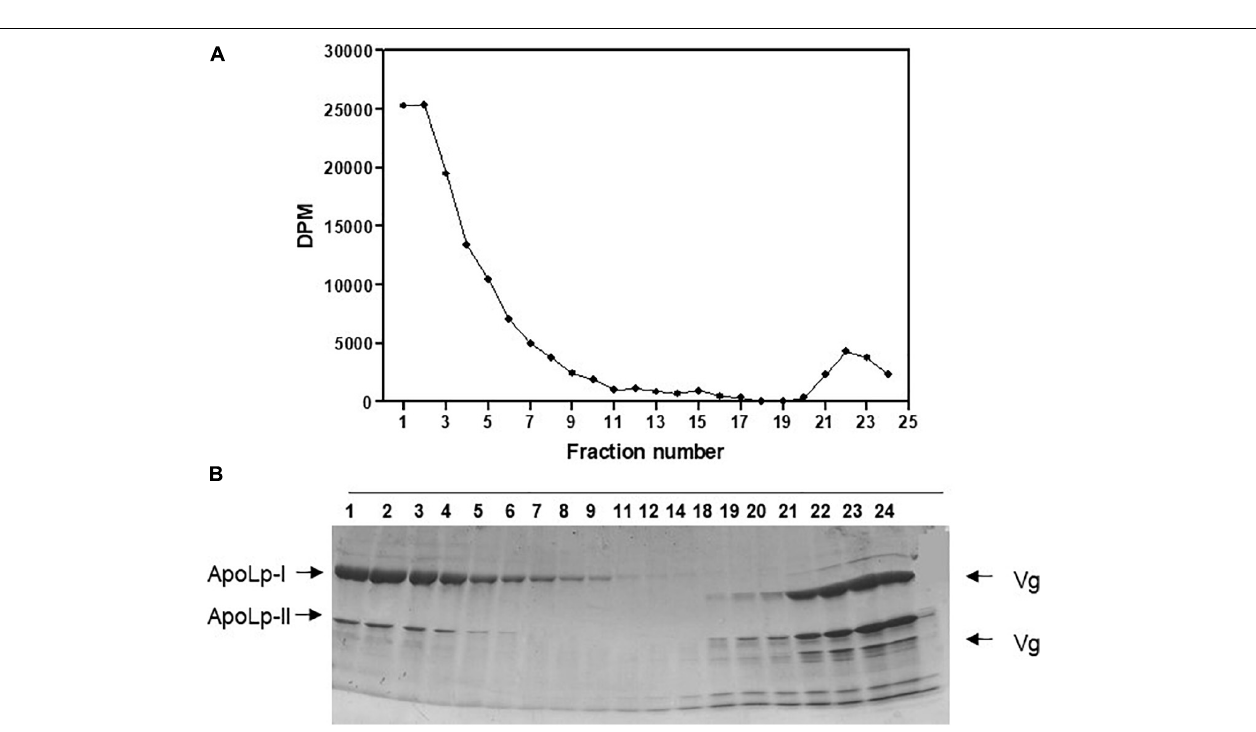
FIGURE 3 | Absorbed cholesterol associates with hemolymphatic lipophorin. Rhodnius prolixus adult females were fed on 3 H-cholesterol-enriched blood and on the sixth day after the blood meal hemolymph was collected and subjected to a density gradient ultracentrifugation. (A) Radioactivity present in gradient fractions was quantified and expressed as DPM/fraction. (B) Fractions were analyzed by SDS-PAGE (6–22%). Results shown are representative of four experiments. ApoLp-I, apolipophorin-I; ApoLp-II, apolipophorin-II; Vg, vitellogenin; DPM, disintegrations per minute; SDS-PAGE, sodium dodecyl sulfate–polyacrylamide gel